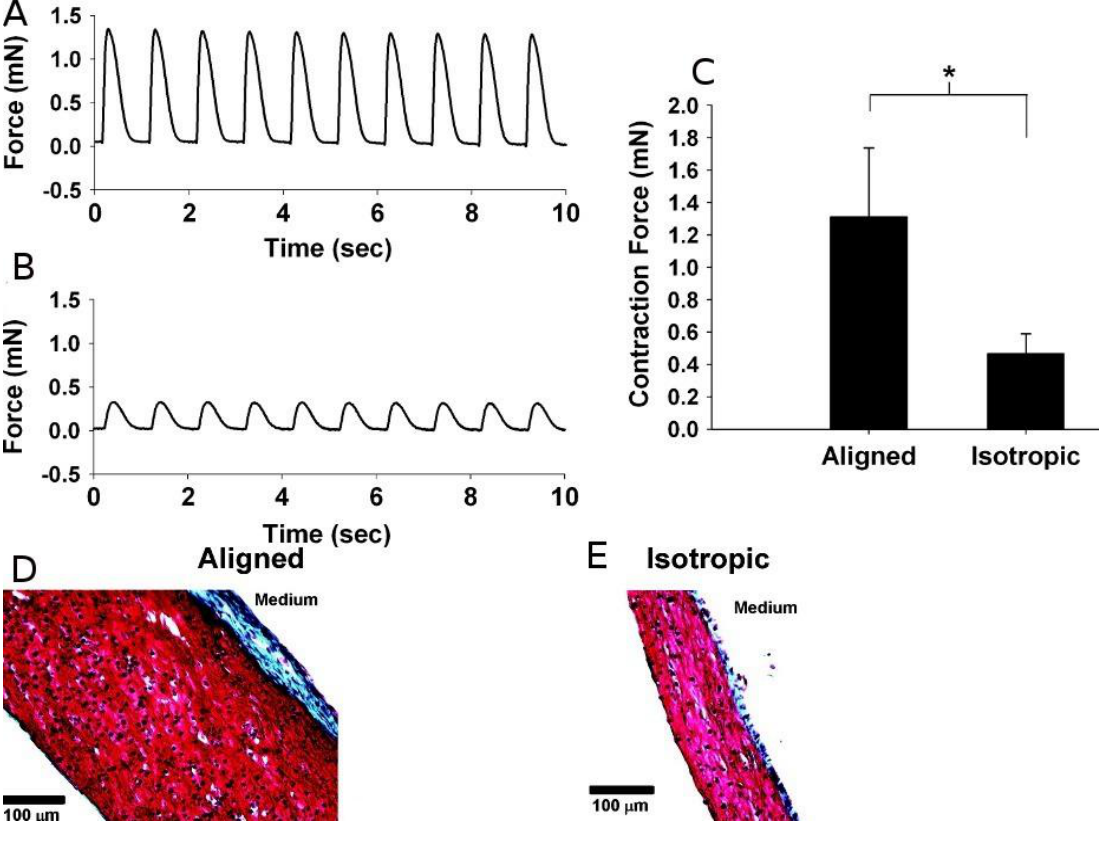
Figure 5. The pacing signal of cultured cardiomyocytes in an ( A ) ―aligned‖ and ( B ) ―isotropic‖ construct. The contract force generated by cells on aligned fibers shows a higher force compared to those on isotropic fibers under electric stimulus ( C ) and Lillies’ trichrome staining for ( D ) ―isotropic‖ and ( E ) ―aligned‖ samples. The aligned cell construct has a thicker cell layer compared to that of isotropic structure